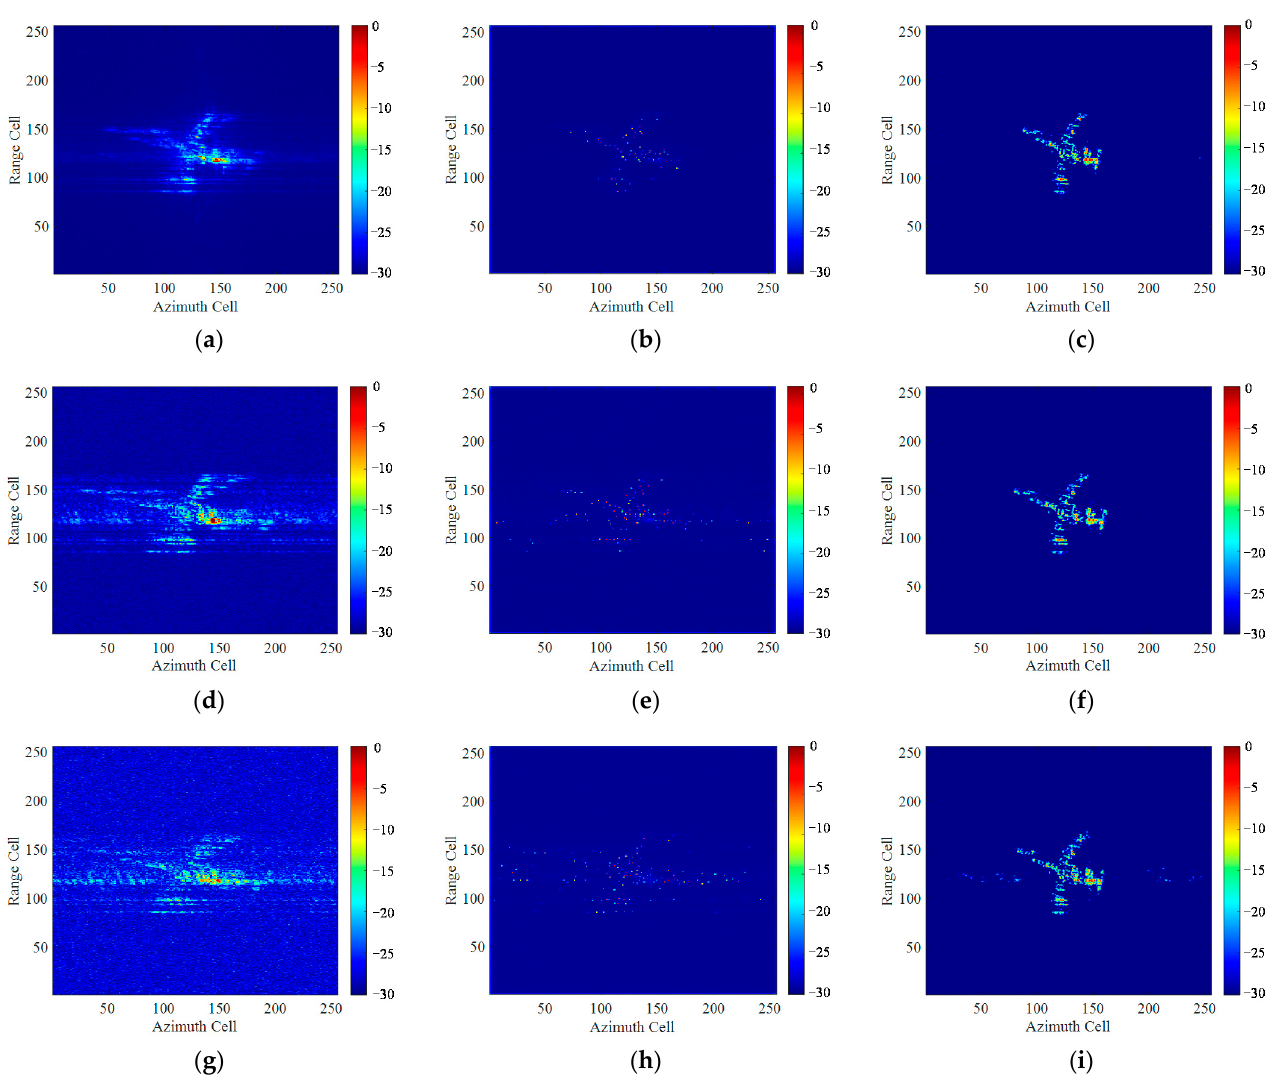
Figure 22. Imaging results of Yak-42 by different methods: ( a , d , g ) RD algorithm; ( b , e , h ) The method in [22]; ( c , f , i ) The proposed method.